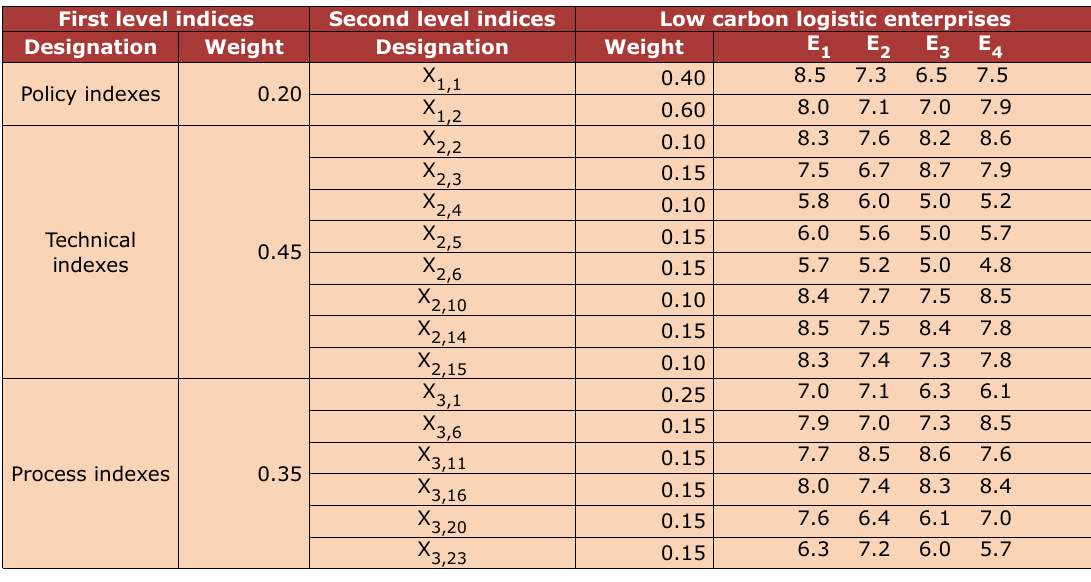
Table 2. Low carbon level evaluation index systems of logistics